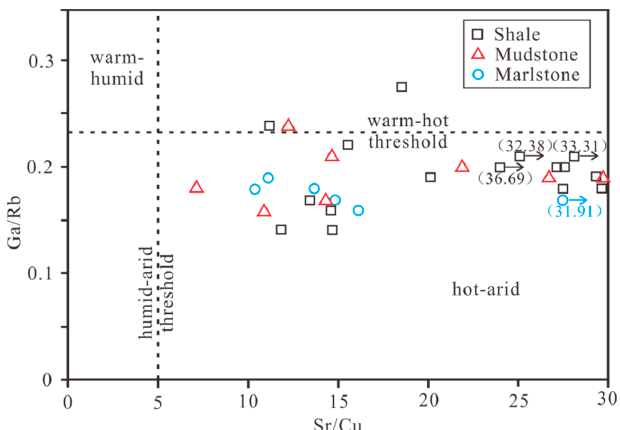
Figure 13. Cross plot of Sr/Cu vs. Ga/Rb ratios showing paleoclimatic conditions.